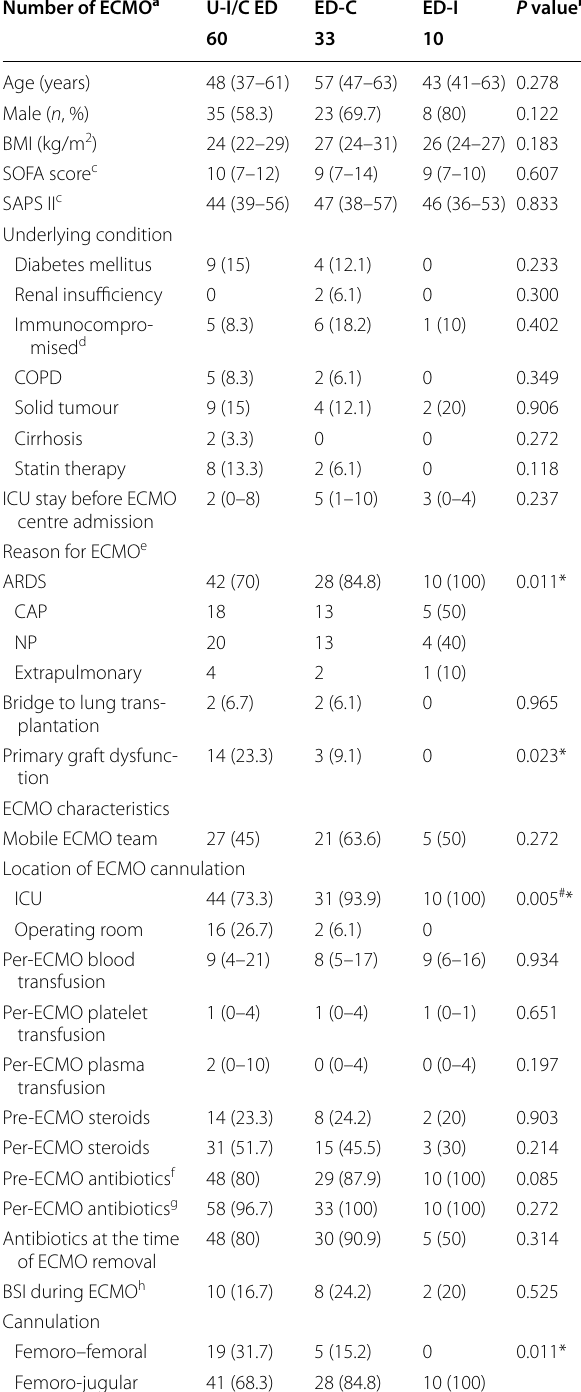
Table 1 General characteristics of ECMO in patients with- out infected/colonised ECMO device, with ECMO device colonisation and ECMO device infection (at the time of ECMO